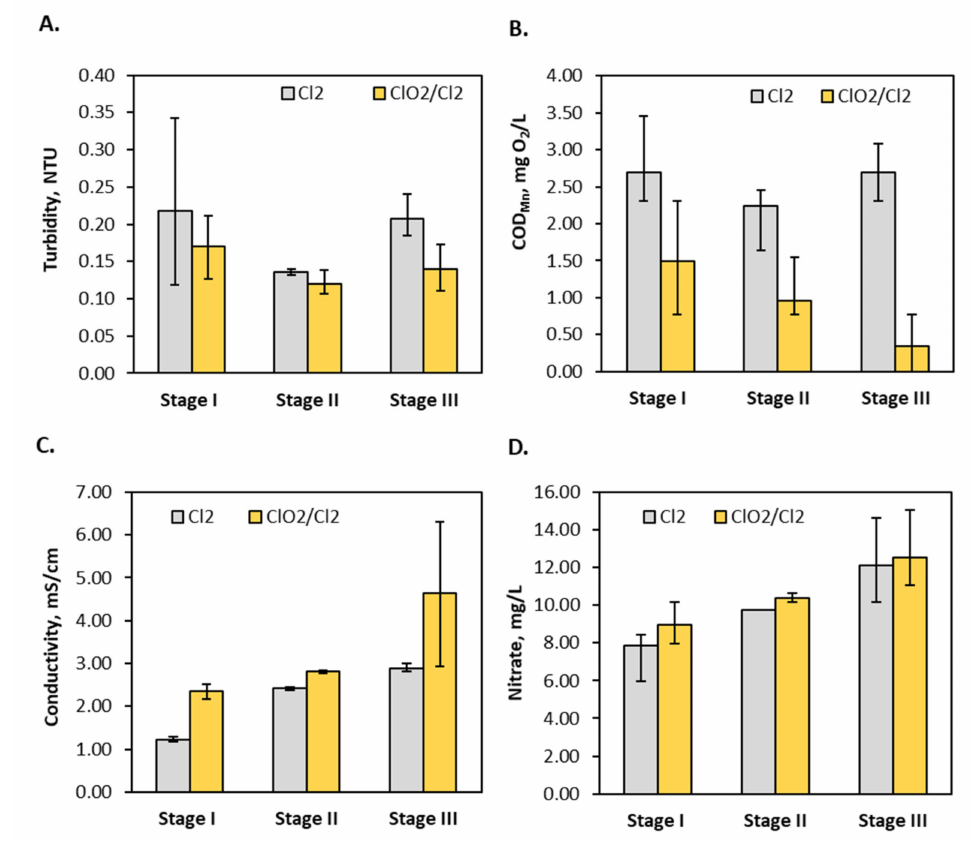
Figure 3. The influence of chlorine dioxide on the physical and chemical parameters of swimming pool water: ( A ) turbidity; ( B ) COD Mn ; ( C ) conductivity; ( D )